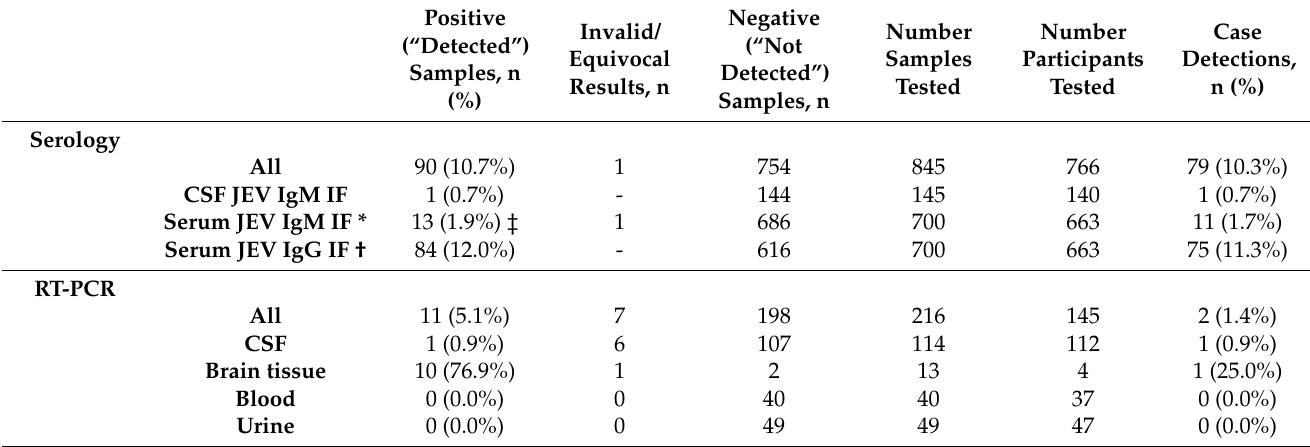
Table 2. Japanese encephalitis testing summary for persons from New South Wales, Australia, including all prospective samples tested over the period 4 March 2022 to 31 May 2022.